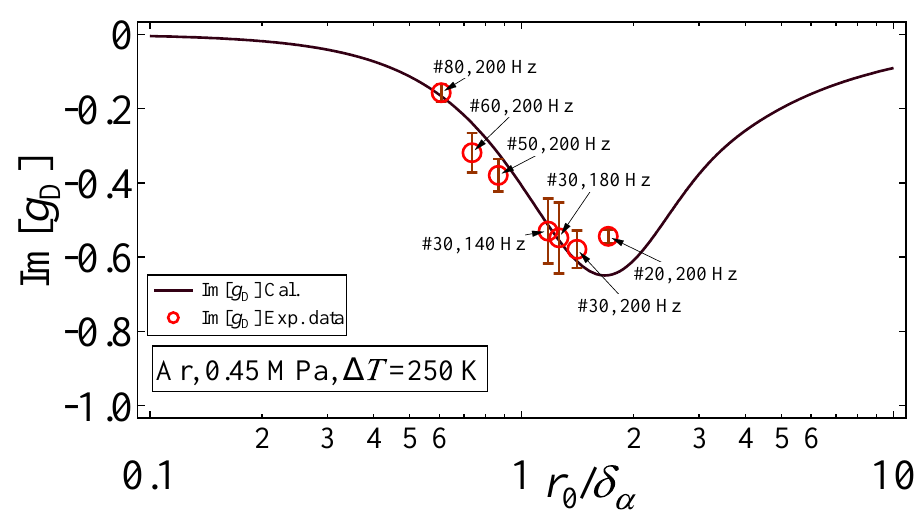
Figure 5. Relation between Im [ g D ] and r 0 / δ α . The curve of Im [ g D ] was calculated from the thermoacoustic theory. The symbols represent the experimental values evaluated from Equation (14) with measured data and the thermal properties of the gas at the hot end of the regenerator ( T H = 543